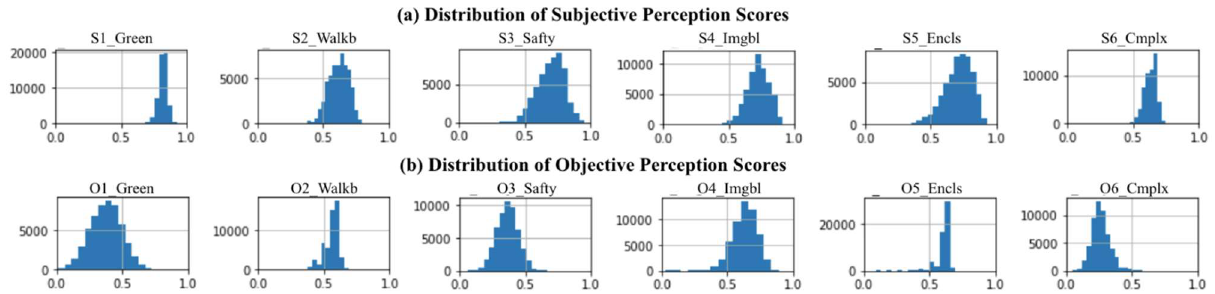
Figure 9. Score distribution. ( a ) Histogram of six subjective scores. ( b ) Histogram of six objective scores.